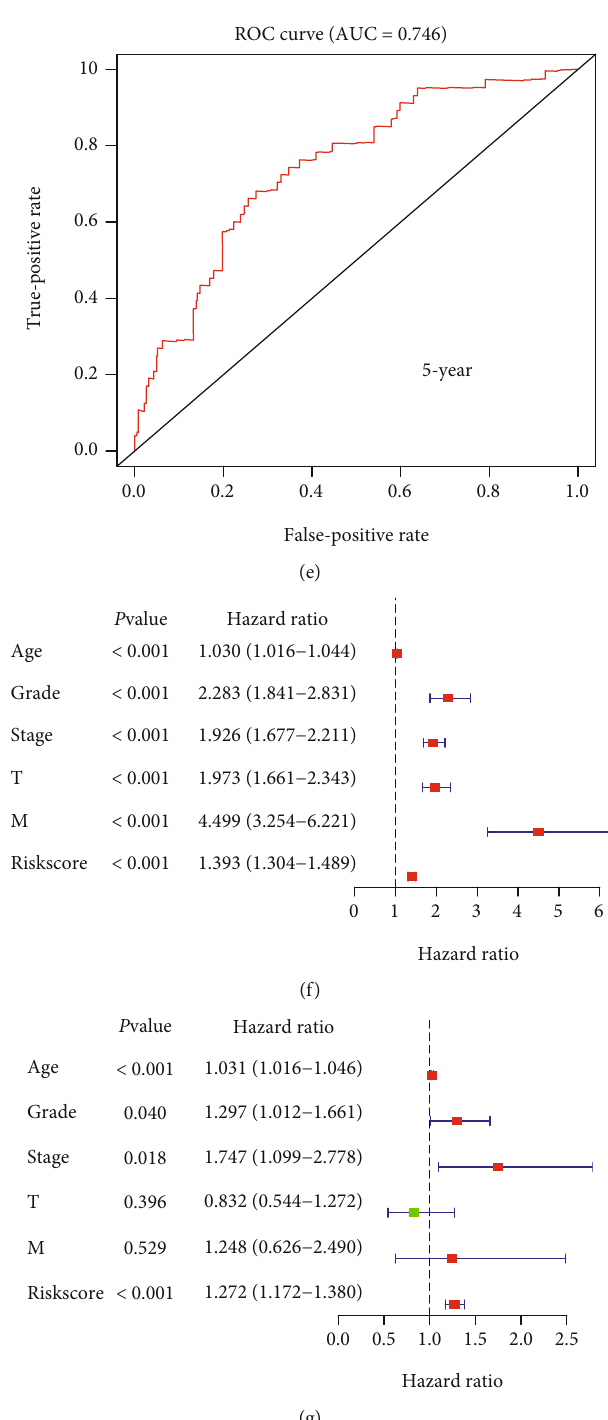
Figure 5: Establishment of the risk signature in KIRC and its correlation with clinical characteristics. (a – c) The process of building the risk signature containing 11 genes in KIRC. (d) Survival curve drawn based on the model. (e) Five-year ROC curve. Results of (f) univariate Cox analysis and (g) multivariate Cox